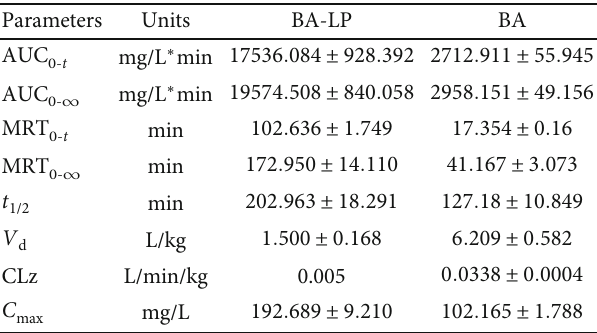
Table 3: Main pharmacokinetic parameters of plasma in normal mice after intravenous injection of BA-LP and BA. Parameters